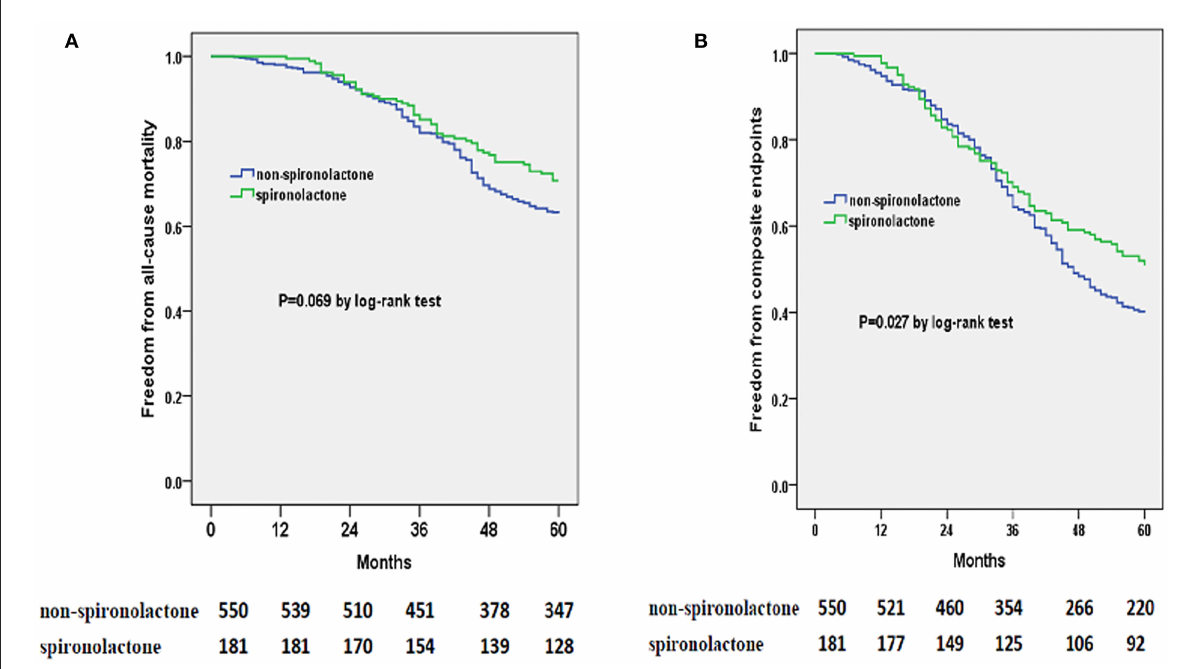
FIGURE2 Kaplan-Meier curves of freedom from all-cause mortality (A) and composite endpoints (B) for spironolactone or non-spironolactone group in HFpEF patients with LVEF < 60% during 5 years of following-up. The numbers at the bottom of the figure are “number at risk.”